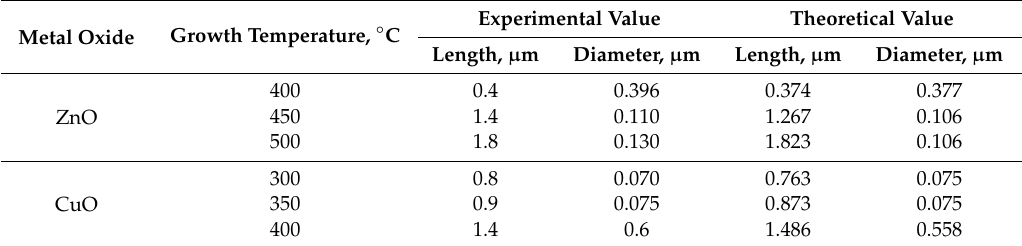
Table 2. Comparison of the experimental and theoretical values for the ZnO and CuO nanostructures synthesized at di ff erent growth temperatures and a growth time of 30